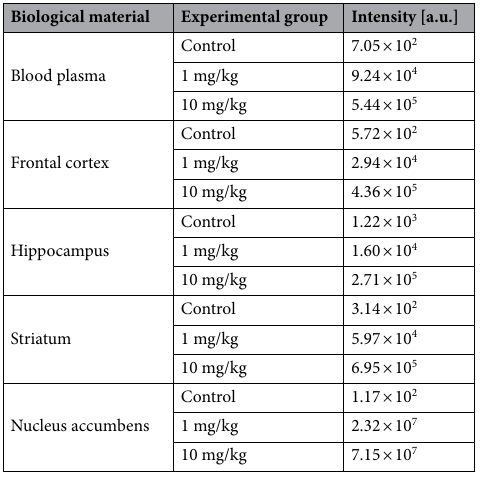
Table 1. Intensity of the 25I-NBOMe precursor ion (~ 428 m / z) from one sample preparation. The analysis was performed 15 min after injection with a single low and high (1 and 10 mg/kg) dose of 25I-NBOMe. The values are presented as intensity per 1 mg of wet tissue or 1 ml of blood serum; a.u. arbitrary